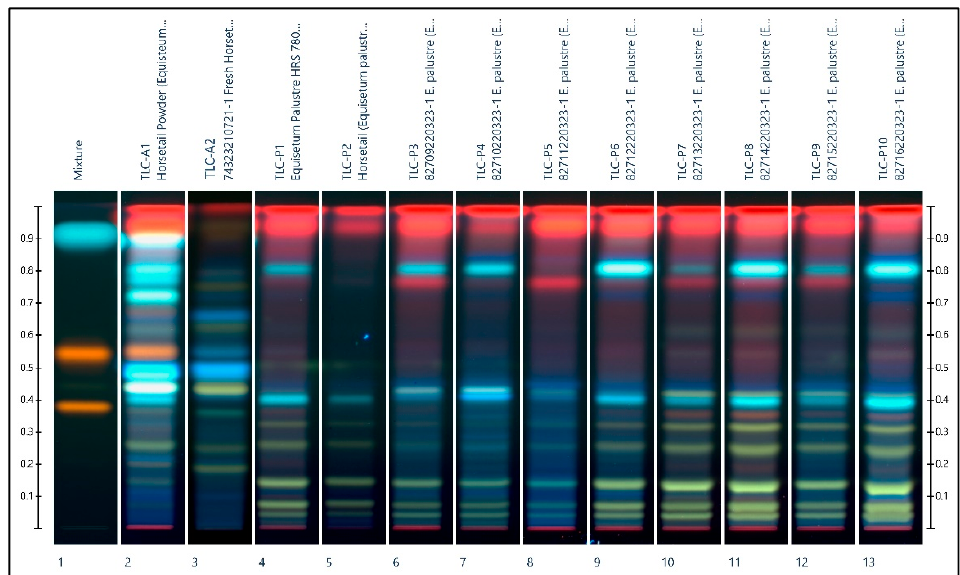
Figure 3. HPTLC chromatogram showing the E. palustre extracts of samples P1 to P10 (tracks 4 to 13). The E. arvense extracts samples A1 and A2 (tracks 2 and 3, respectively) are also shown for comparison. The chemical standards rutin, hyperoside, and caffeic acid are present in ascending order on track 1.